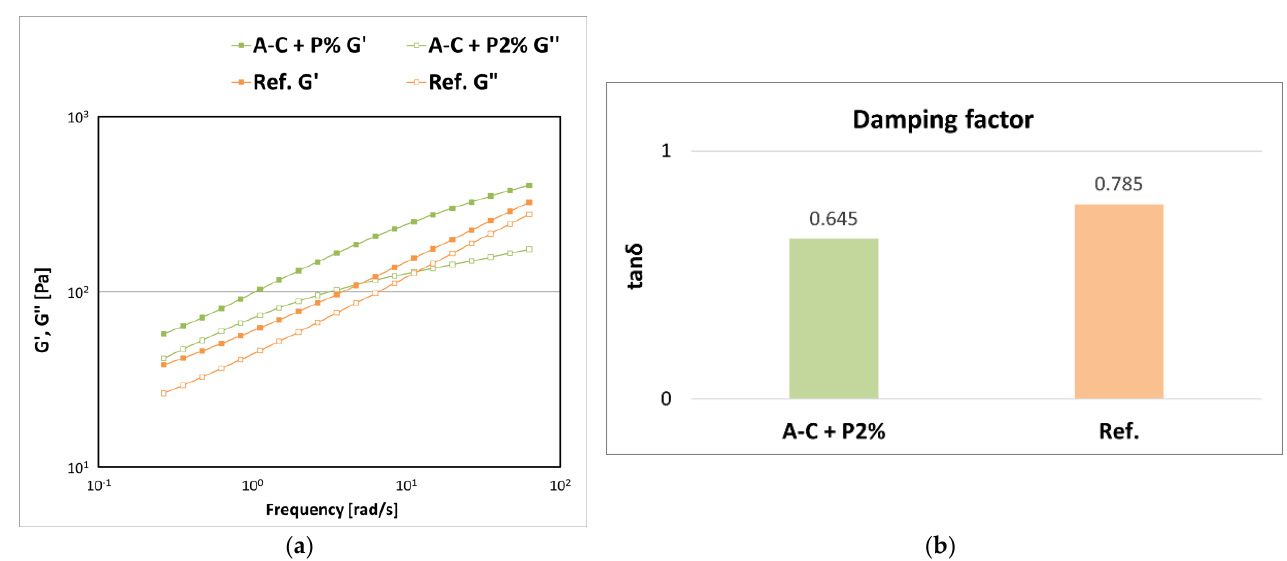
Figure 20. Storage (G′) and loss (G″) moduli trend as a function of the frequency ( a ) and damping factor tanδ taken at 0.5 Hz ( b ) measured for the sample prepared with ternary associations of A (1.25% w/w), C (1% w/w), and P (2% w/w) com- pared with the reference product (Ref.).